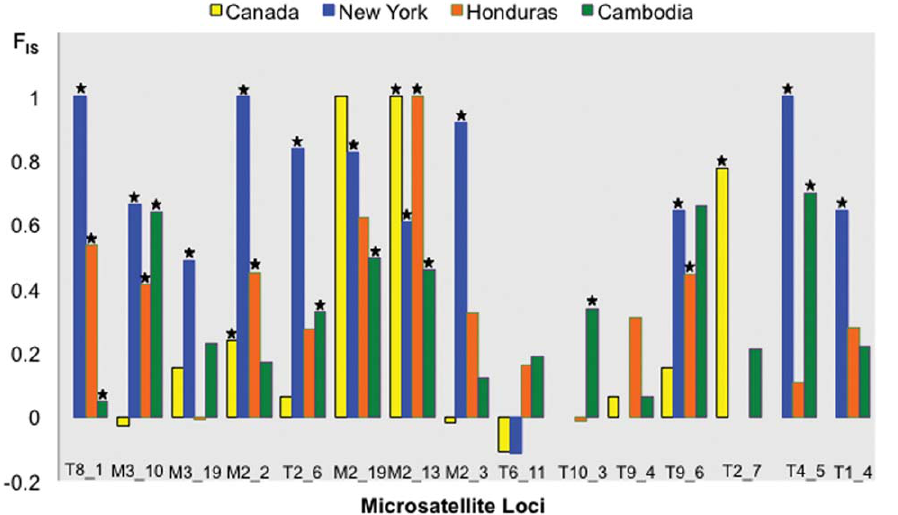
Figure 3. F IS estimates by locus within populations. For monomorphic loci estimates were not calculated and they are shown in the graphs as gaps. Stars indicate significant departure from Hardy-Weinberg equilibrium ( P , 0.05).